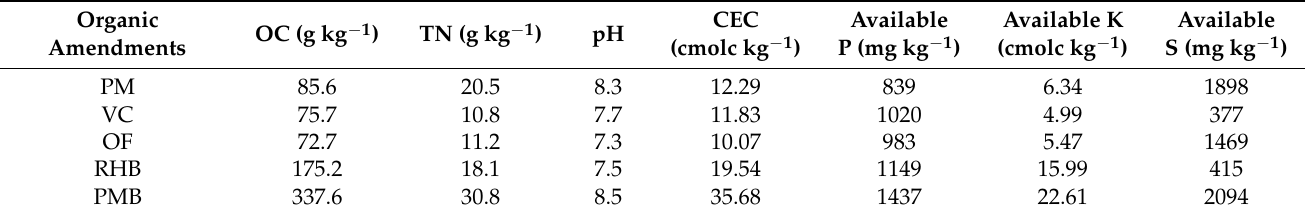
Table 2. Chemical properties of organic amendments used in